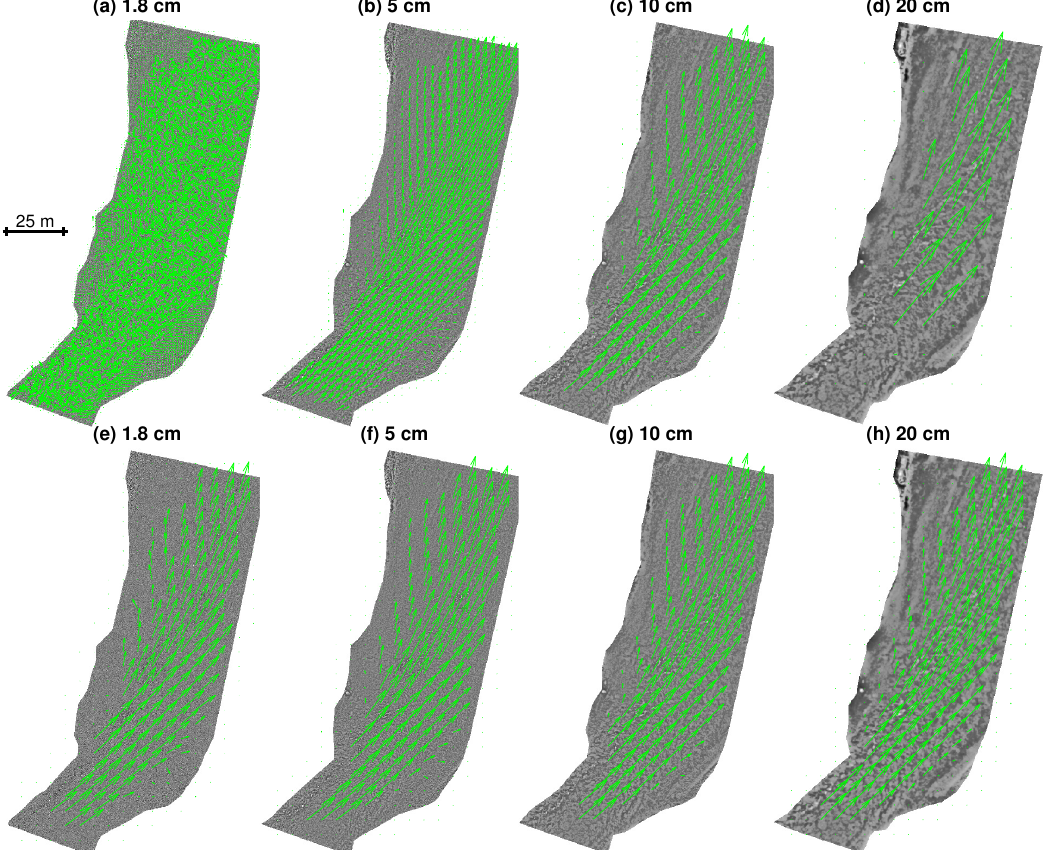
Figure 6. Comparison of PIV-derived velocity fields derived from images with varying pixel sizes for fixed PIV parameters (top row) and fixed output vector spacing (bottom row). Note that the vector length in the top row is dictated by the spacing between vector origins and does not scale with the magnitude of the velocity vectors, which is similar across the four